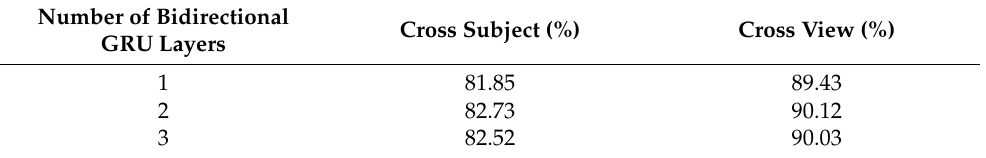
Table 6. Comparison of different bidirectional GRU layers in the NTU RGB+D dataset.